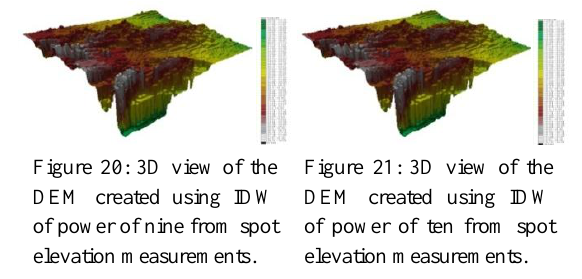
Figure 21: 3D view of the DEM created using IDW of power of ten from spot elevation measurements.